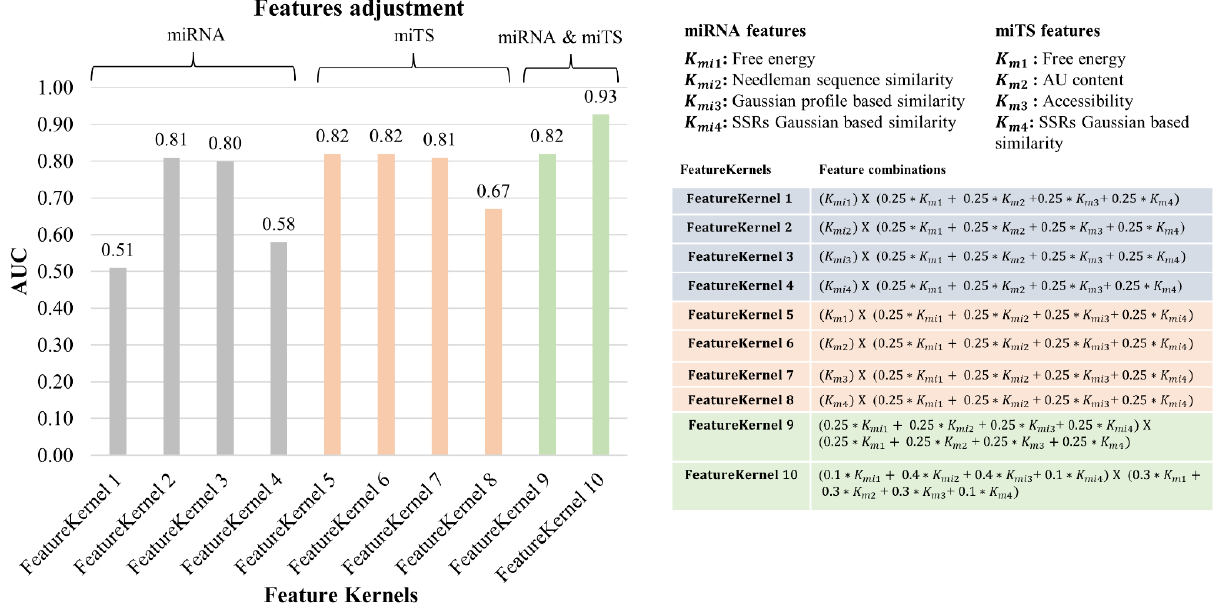
Figure 5. The model performance using different weights combinations of miRNA and mRNA tar- get site features. SSR: Simple sequence repeats, miRNA: microRNA, miTS: miRNA Target Sites.